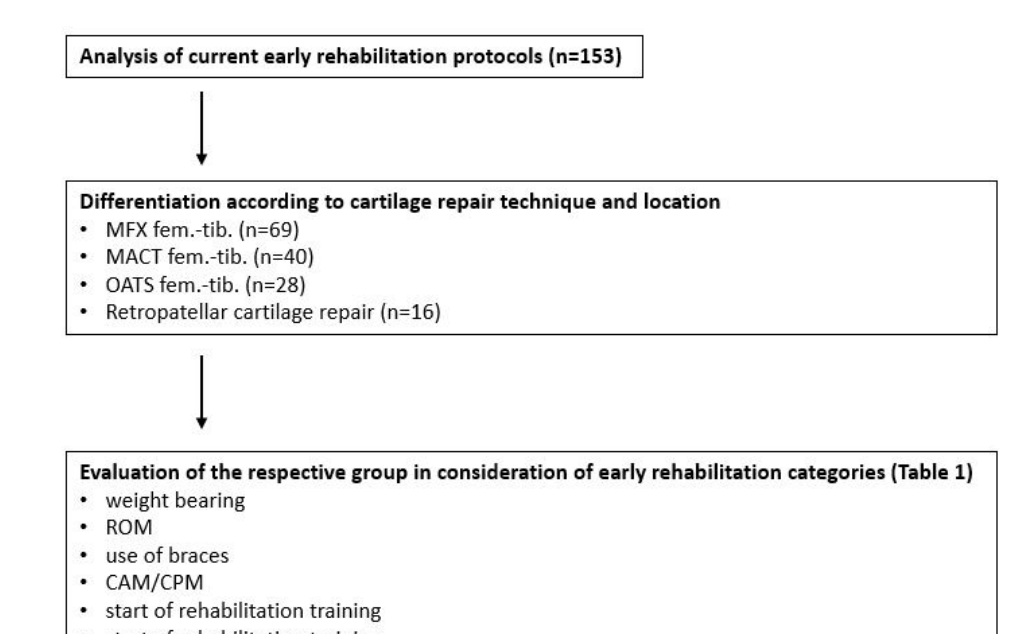
Figure 1. Flow of evaluation. MFX: microfracturing; fem./tib.: femorotibial compartment/main load-carrying area; MACT: matrix-assisted cartilage transplantation; OATS: osteochondral autograft transfer system; ROM: range of motion; CAM/CPM: continuous active/passive motion.